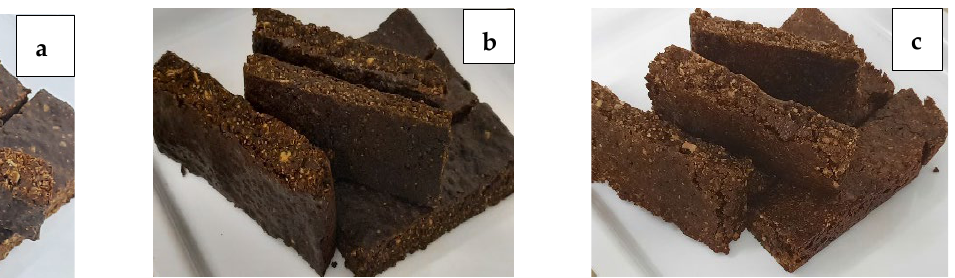
Figure 2. Physical appearance of BAMOnut snack bars—( a ): BAMOnut enriched with oats and 3% BAMOLP (BAMOnut-OB3), ( b ): BAMOnut enriched with millet and 2% BAMOLP (BAMOnut-MB2), and ( c ): BAMOnut enriched with oats, millet, and 5% BAMOLP (BAMOnut-OMB5).